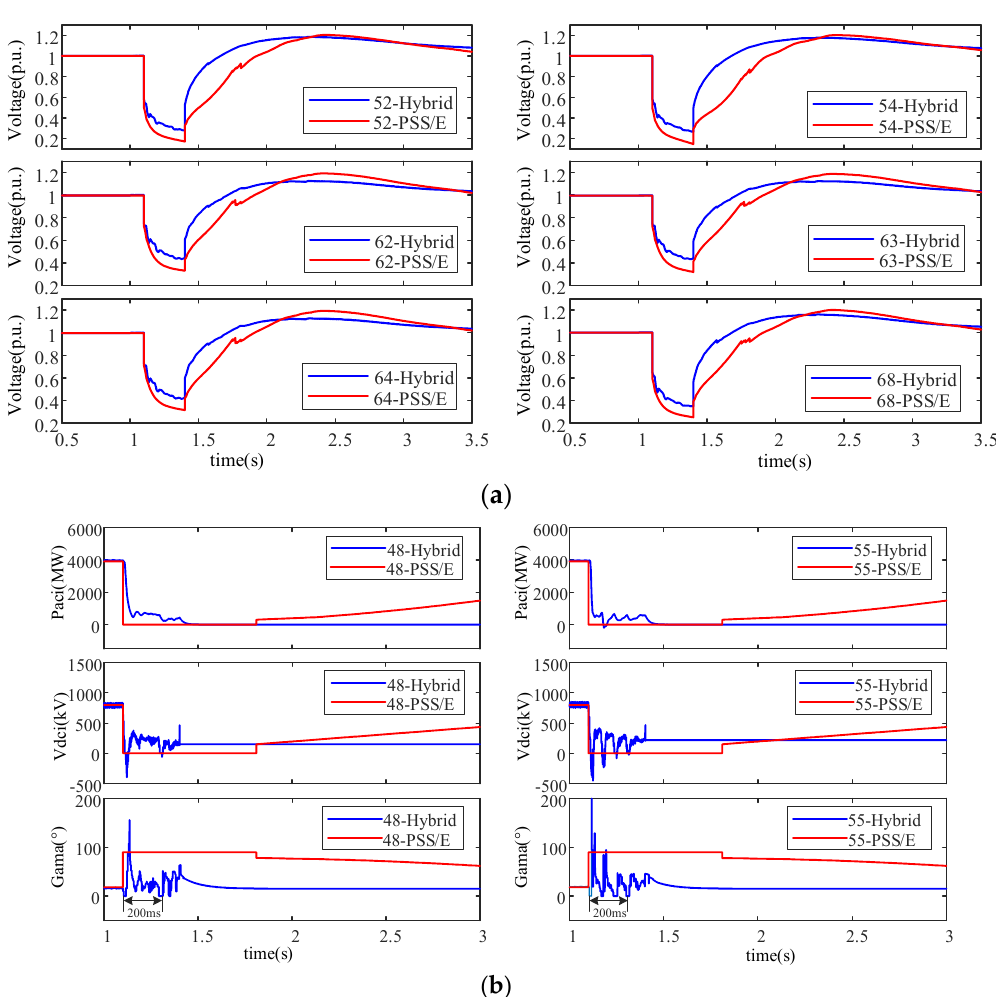
Figure 7. ( a ) Voltage of typical interface buses; ( b ) Active power, dc voltage, and extinction angle at the inverter side of HVDC 2.